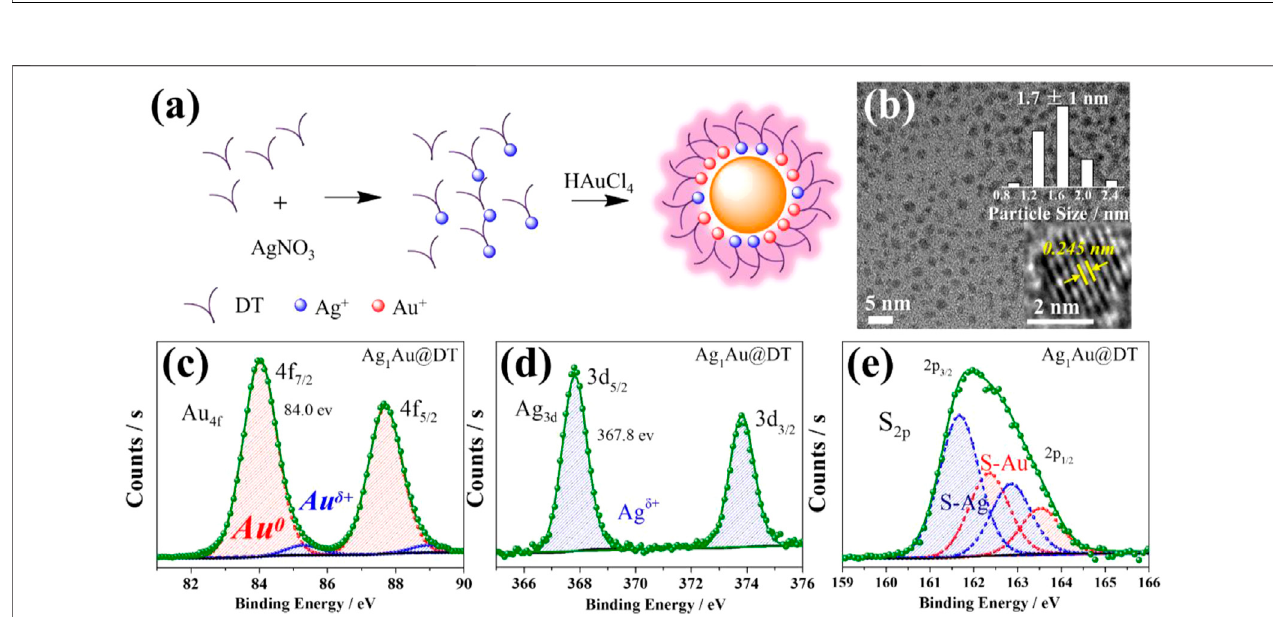
FIGURE 2 | Scheme for the synthesis process of Ag 1 Au@DT NCs (A) , TEM (B) , inset, particle size distribution was determined by measuring the diameters of at least 100 metal NCs.) and XPS spectrum of Au 4f (C) , Ag 3 days (D) and S 2p (e) for Ag 1 Au@DT NCs.